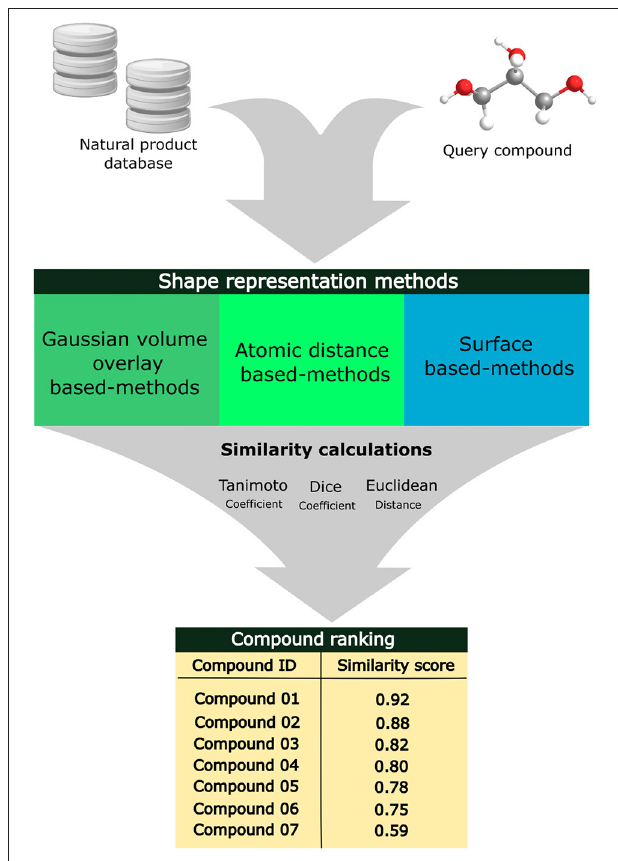
FIGURE 4 | Applications of alignment-based 3D shape-similarity search methods to identify compounds with similar molecular shapes.